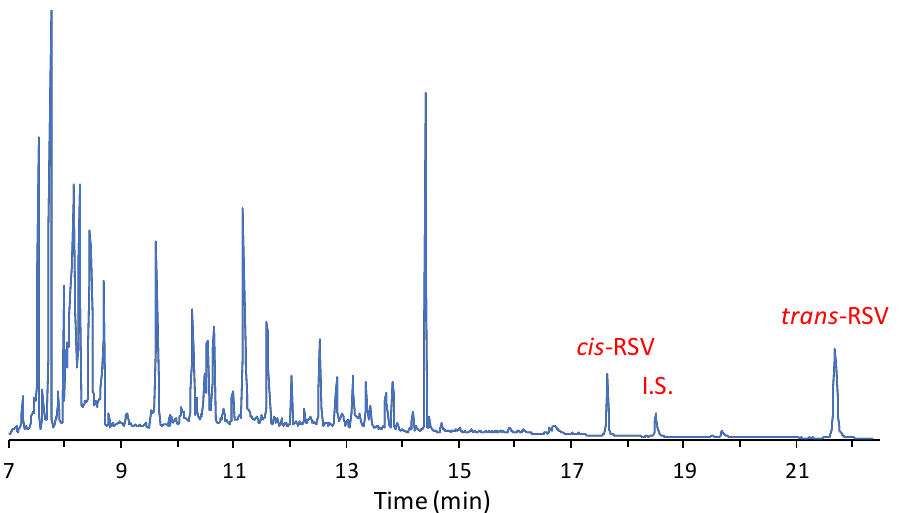
Figure 5. Typical GC–MS chromatogram of a red wine sample derivatized with ethylchloroformate.